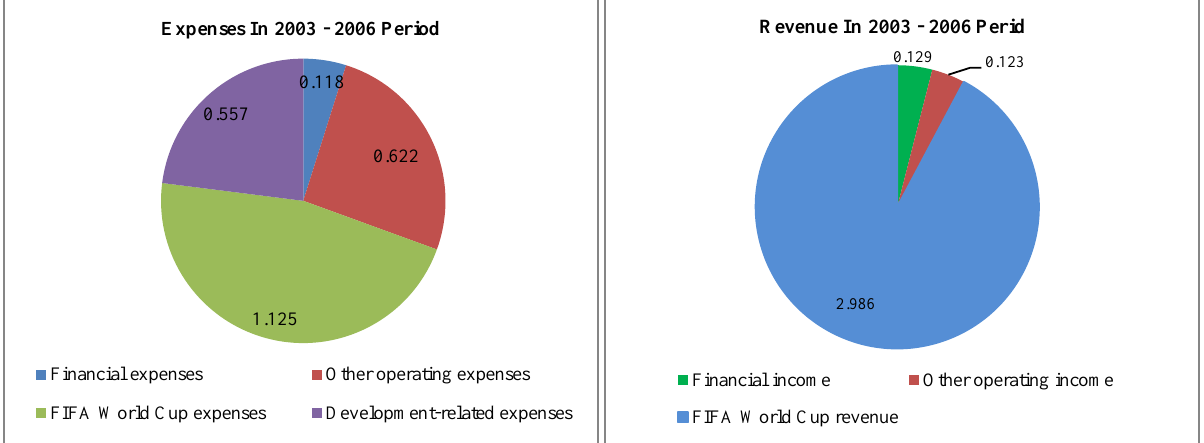
Figure 3. FIFA's revenues and expenses in the 2006 World